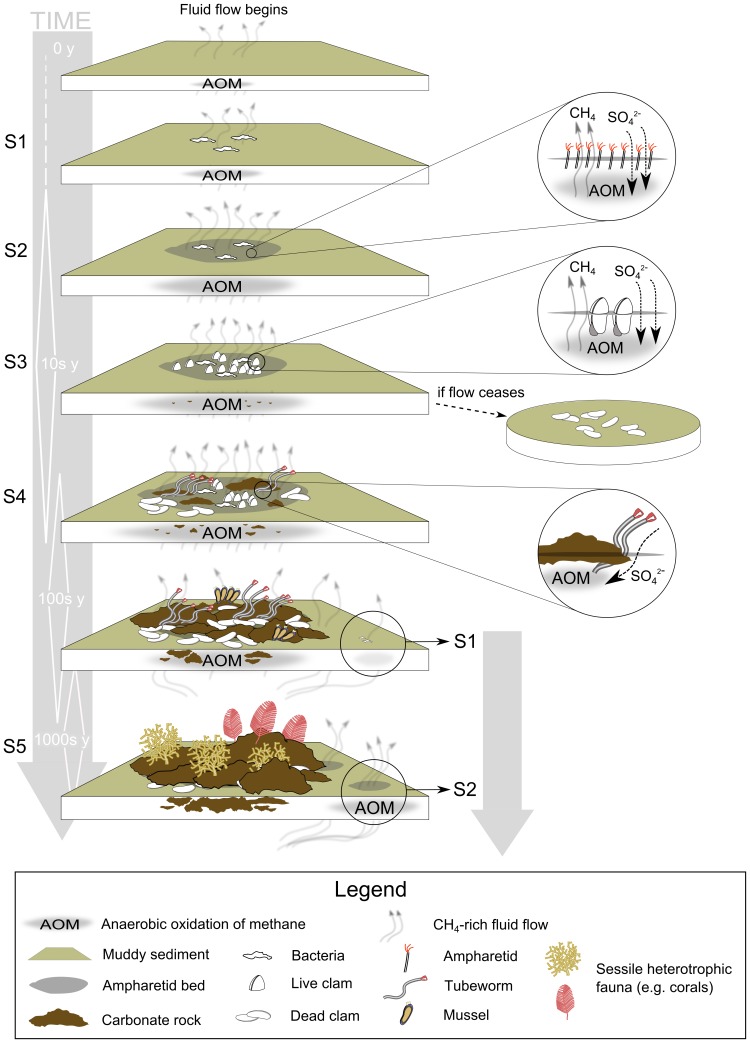
Hypothetical succession sequence at Hikurangi Margin cold seep sites.Labels ‘S1’, ‘S2’, etc., indicate Successional Stages as described in the discussion text.